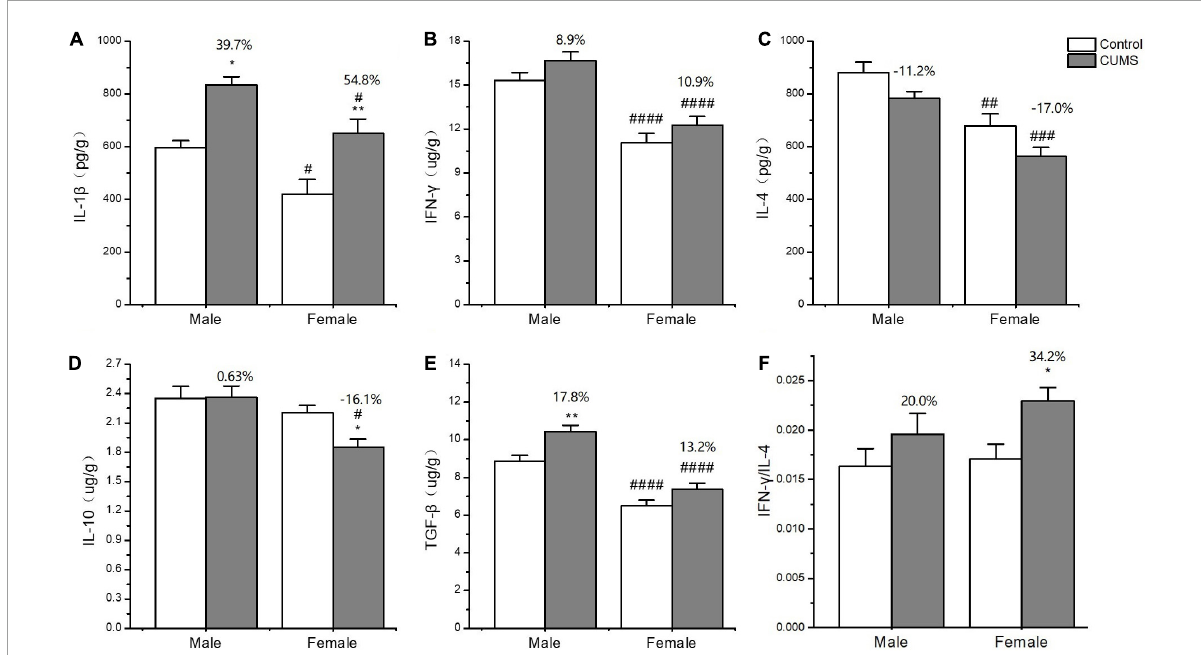
FIGURE8 The changes of inflammation cytokines in the hippocampus of male and female rats. (A–F) The concentrations of inflammation cytokines of IL-1 β , IFN- γ , IL-4, IL-10, and TGF- β , and the ratio of IFN- γ /IL-4 in the hippocampus. * p < 0.05, ** p < 0.01 vs. control with same sex, # p < 0.05, ## p < 0.01, ### p < 0.001, and #### p < 0.0001 vs. male in same control or CUMS group.